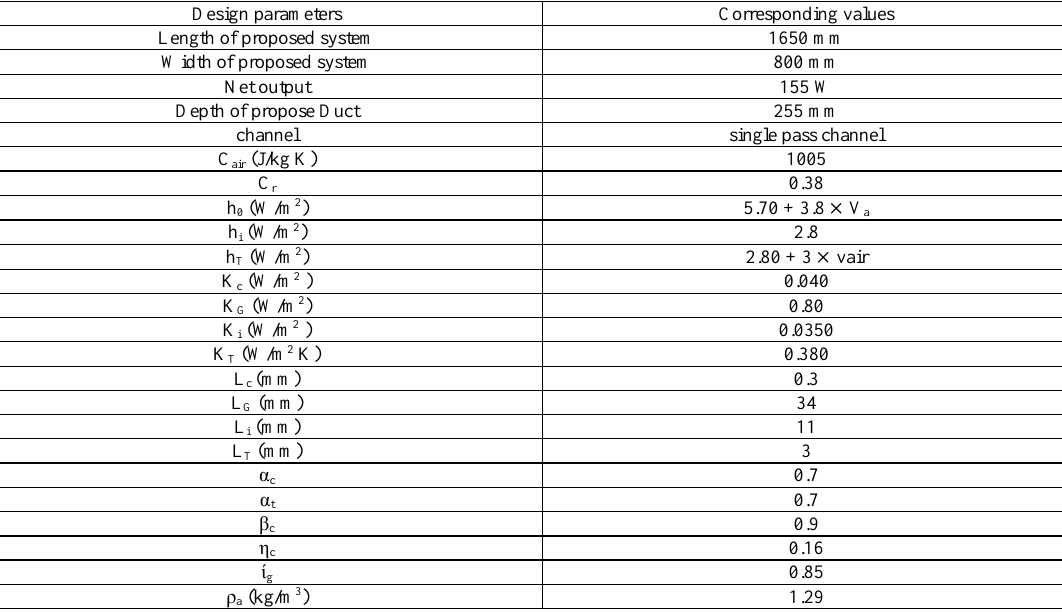
Table 2. Design parameters of proposed